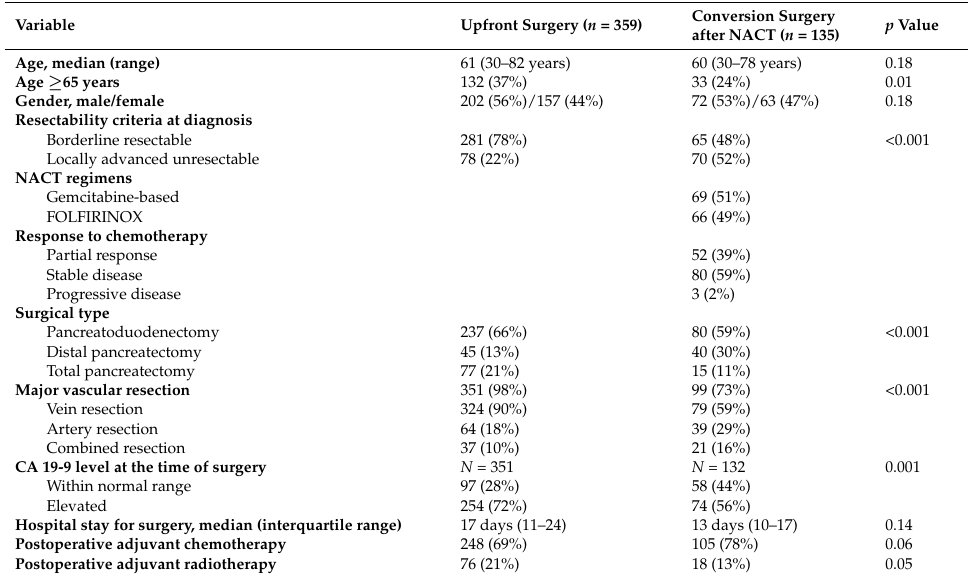
Table 1. Patient characteristics.